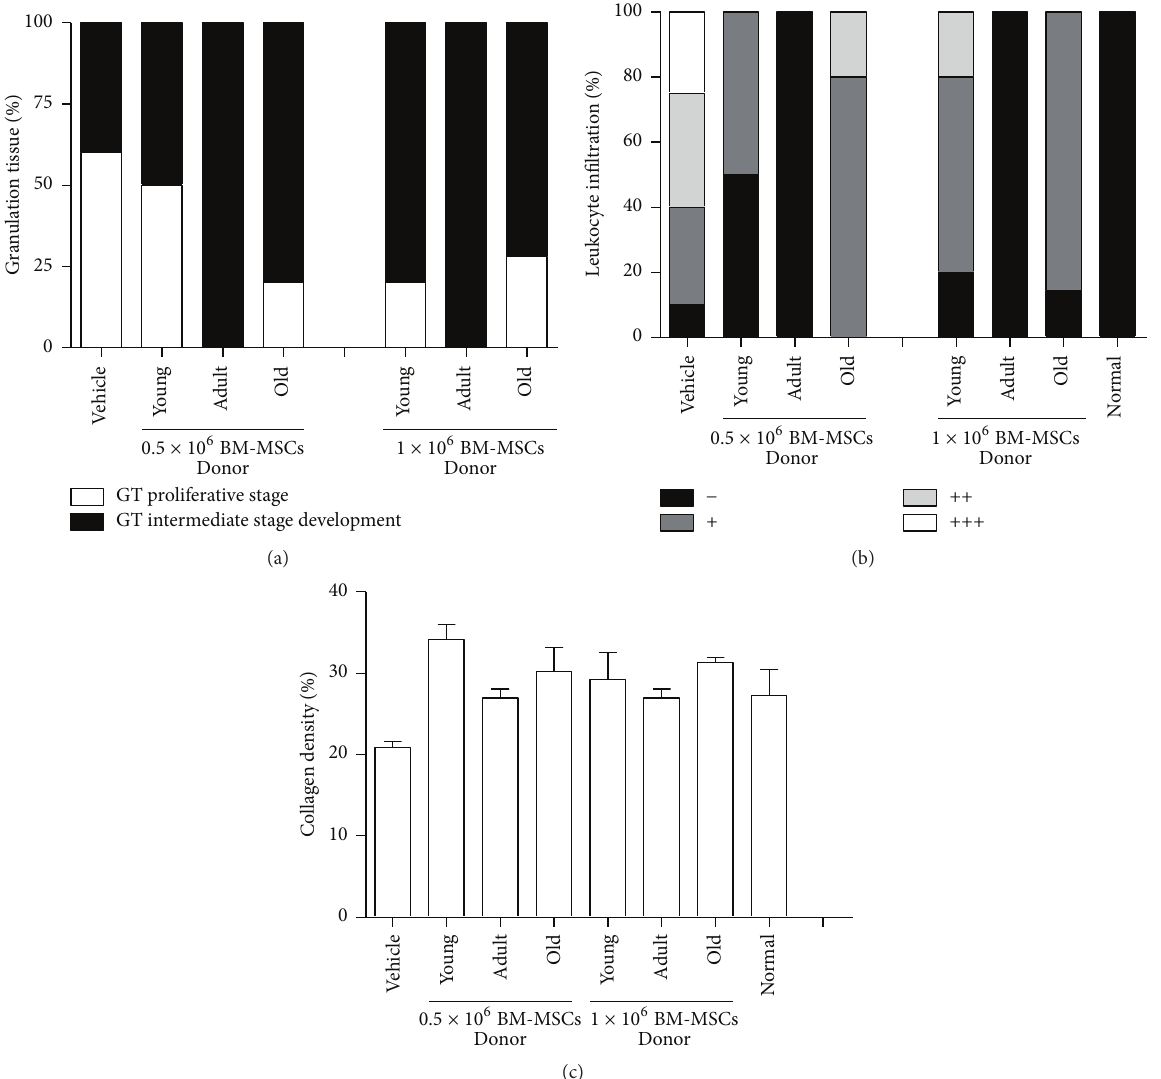
Figure3:SyngeneicBM-MSCsledtoskinhealingprocess.Frequency(%)ofanimalswithdifferenthistologicalscoresof(a)granulationtissue formationtypeand(b)leukocyteinfiltrationinthedermis.(c)Quantitativeanalysisofdensityofdermalcollagenfibers.Representativeresults for 6–15 animals per experimental